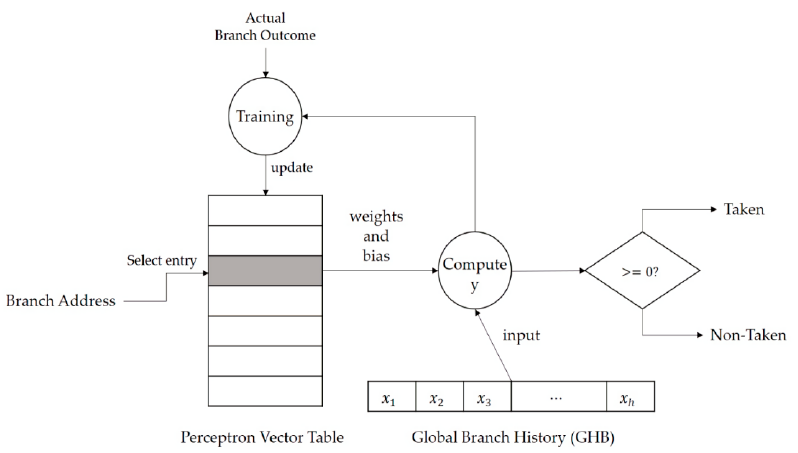
Figure 6. Perceptron Predictor Block Diagram [9]: After selecting the parameter corresponding to the branch address, compute dot product the parameter with the previous branch history, and the predictor decides if the branch is taken or not based on the result.3.3. Perceptron based Branch Predictor.